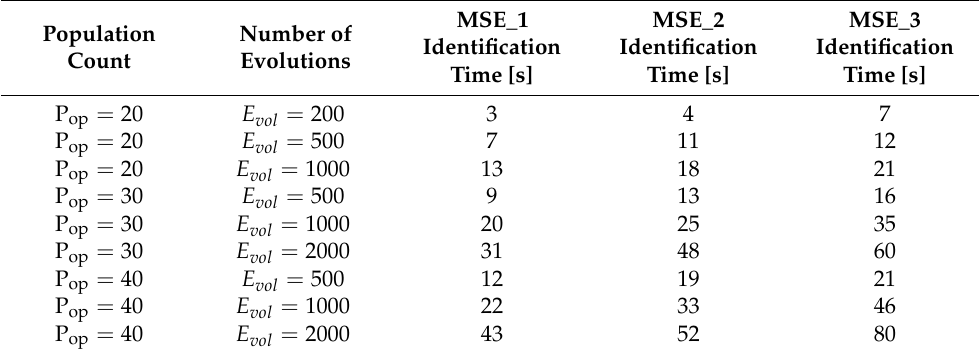
Table 2. Time of decomposed function parameters identification depending on DE algorithm param- eters change.